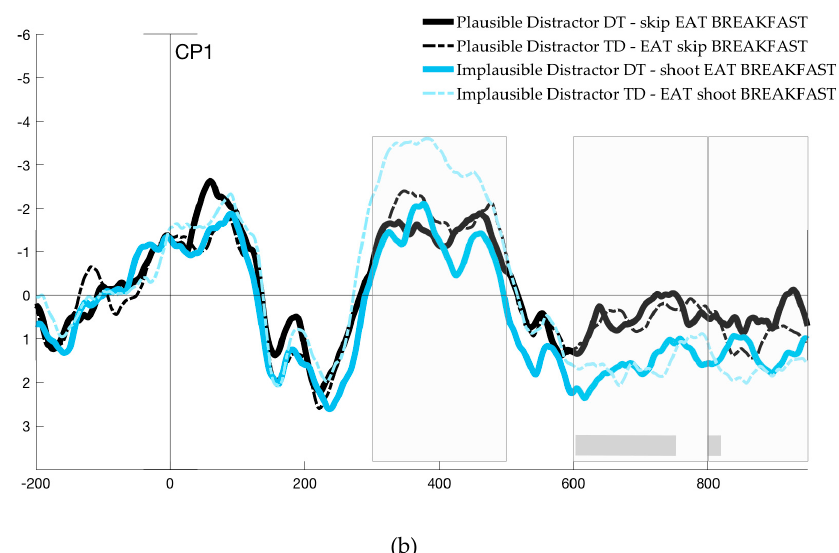
Figure 6. ERP waveforms for non-native speakers at ( a ) FC6 (right frontocentral) and ( b ) CP1 (left centroparietal). The legend shows examples for each condition, with the target verb capitalized. Grey bars underneath show the time points of significant effects in running t -tests within the pre-defined 500–950 ms time window. Boxes show the three time windows analyzed. The arrow in (b) indicates the N inc effect. Negativity is plotted up.